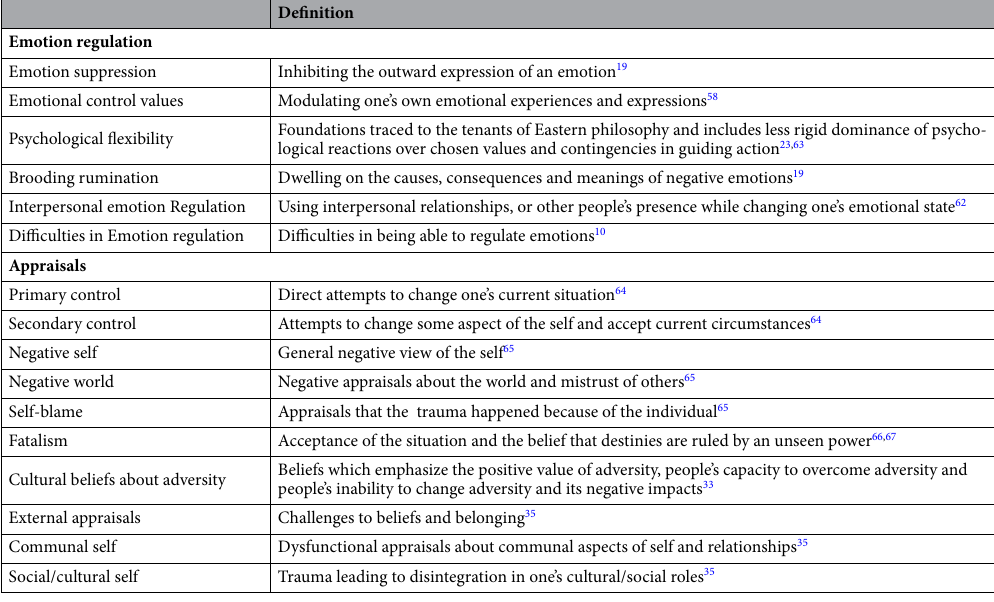
Table 1. Definitions of the emotion regulation and cognitive appraisals included in this